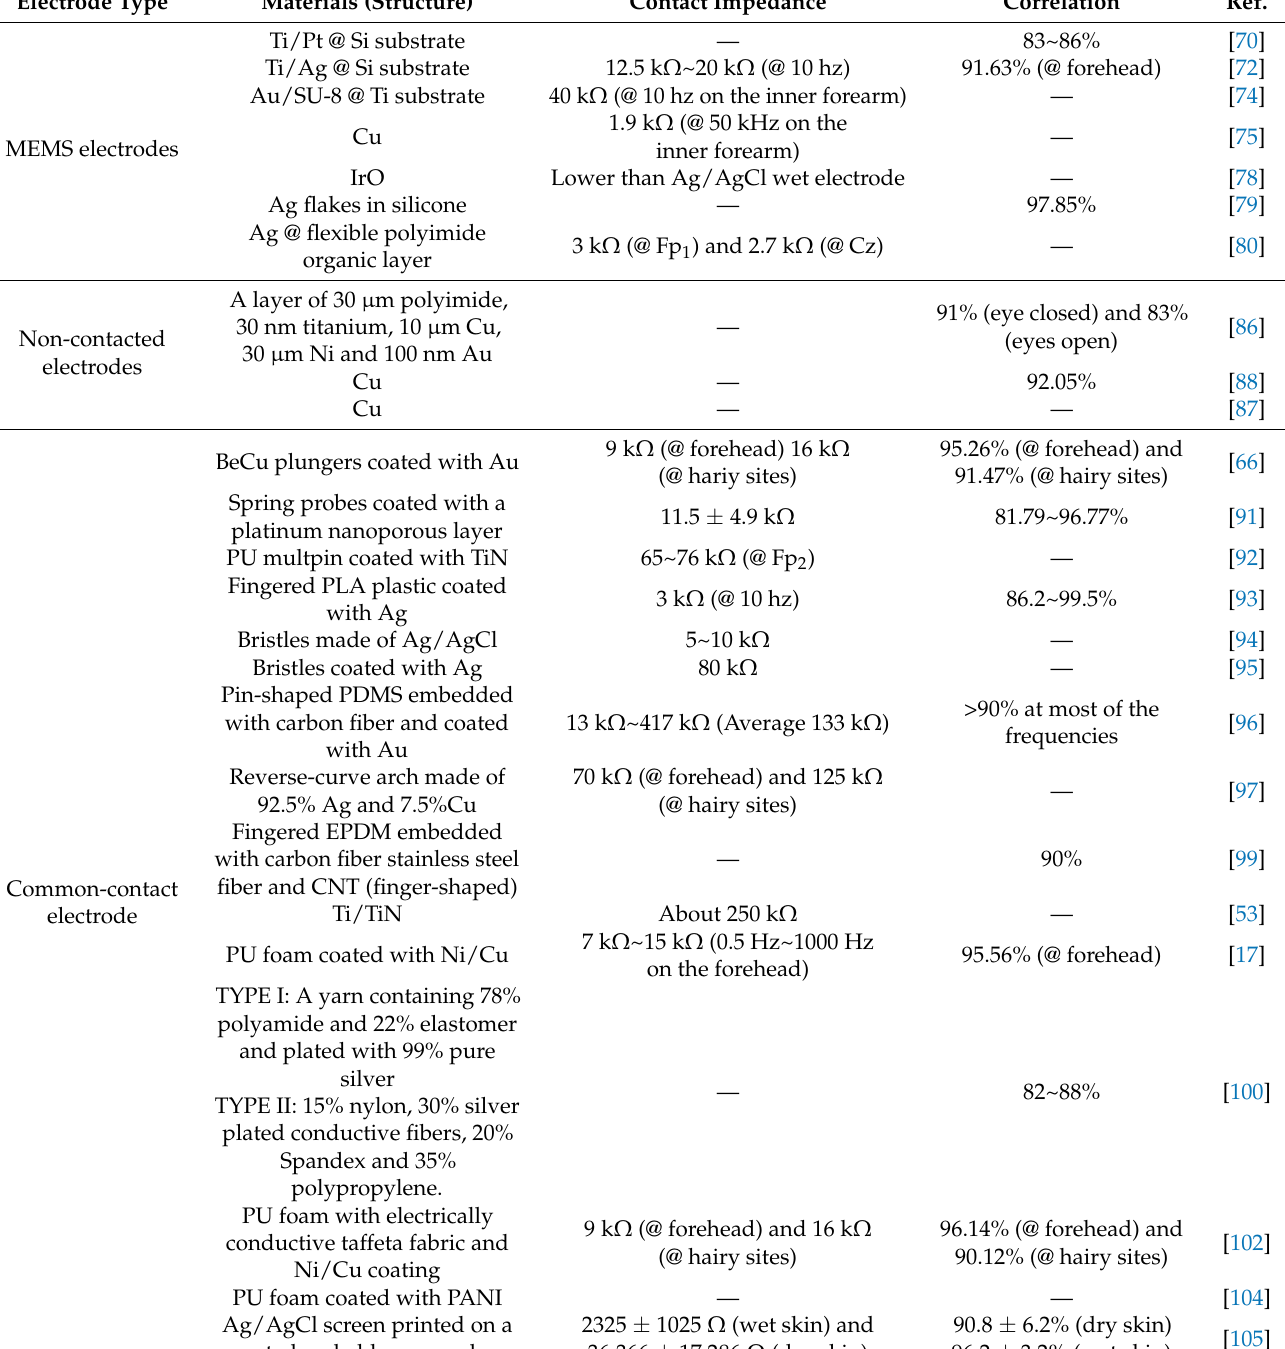
Table 1. Materials, structures, and properties of some EEG